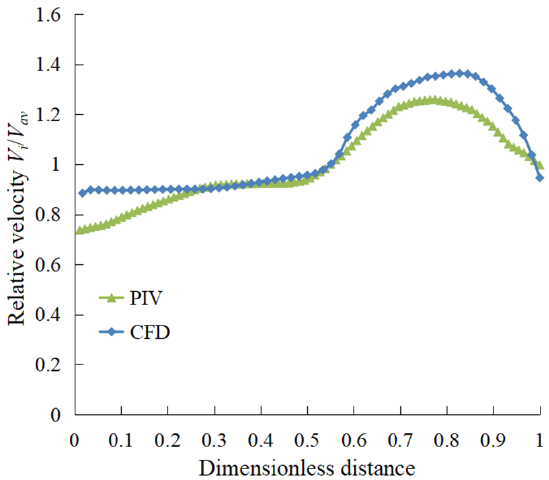
Figure 9. Comparison between PIV test value and CFD calculated value(0.6 Q bep ).